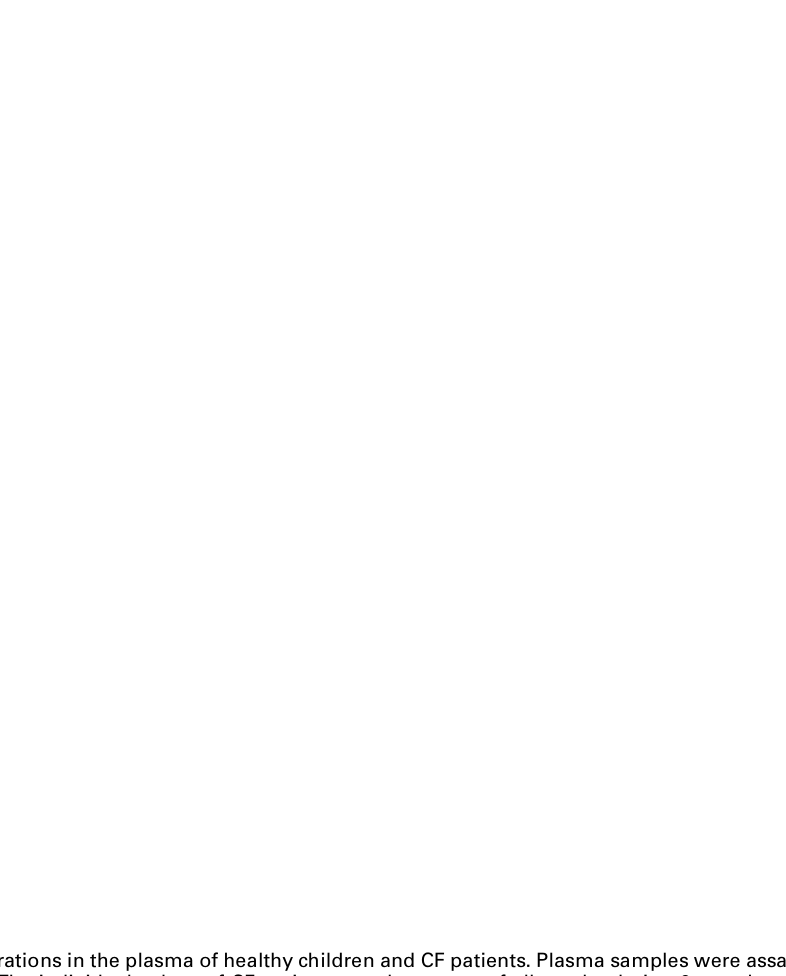
FIG. 1. Cytokine concentrations in the plasma of healthy children and CF patients. Plasma samples were assayed for TNF- a (A) and IL-10 (B) by ELISA. The individual values of CF patients are the means of all results during 6 months of the observation period. Median values are indicated by the lines. Each dot represents one subject. A two-sample Wilcoxon test was used to compare the cytokine levels in healthy group before and after vaccine administration: TNF- a (A), p 1,2 = 0.32, p 1,3 = 0.001; IL-10 (B), p 1,2 = 0.27, p 1,3 = 0.038. Differences between CF patients and healthy children were analyzed using the unpaired Wilcoxon test: TNF- a (A), p 1,4 = 0.55; IL-10 (B), p 1,4 = 1). Note that in response to rubella vaccination, both cytokines in the plasma